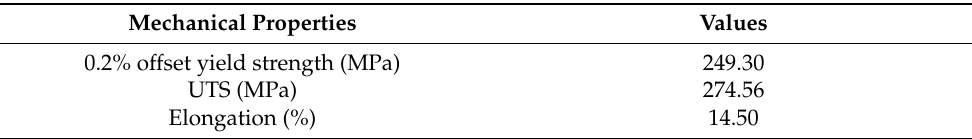
Table 3. Tensile Properties of the Al alloy 6061 in heat-treated condition, before deformation. Mechanical